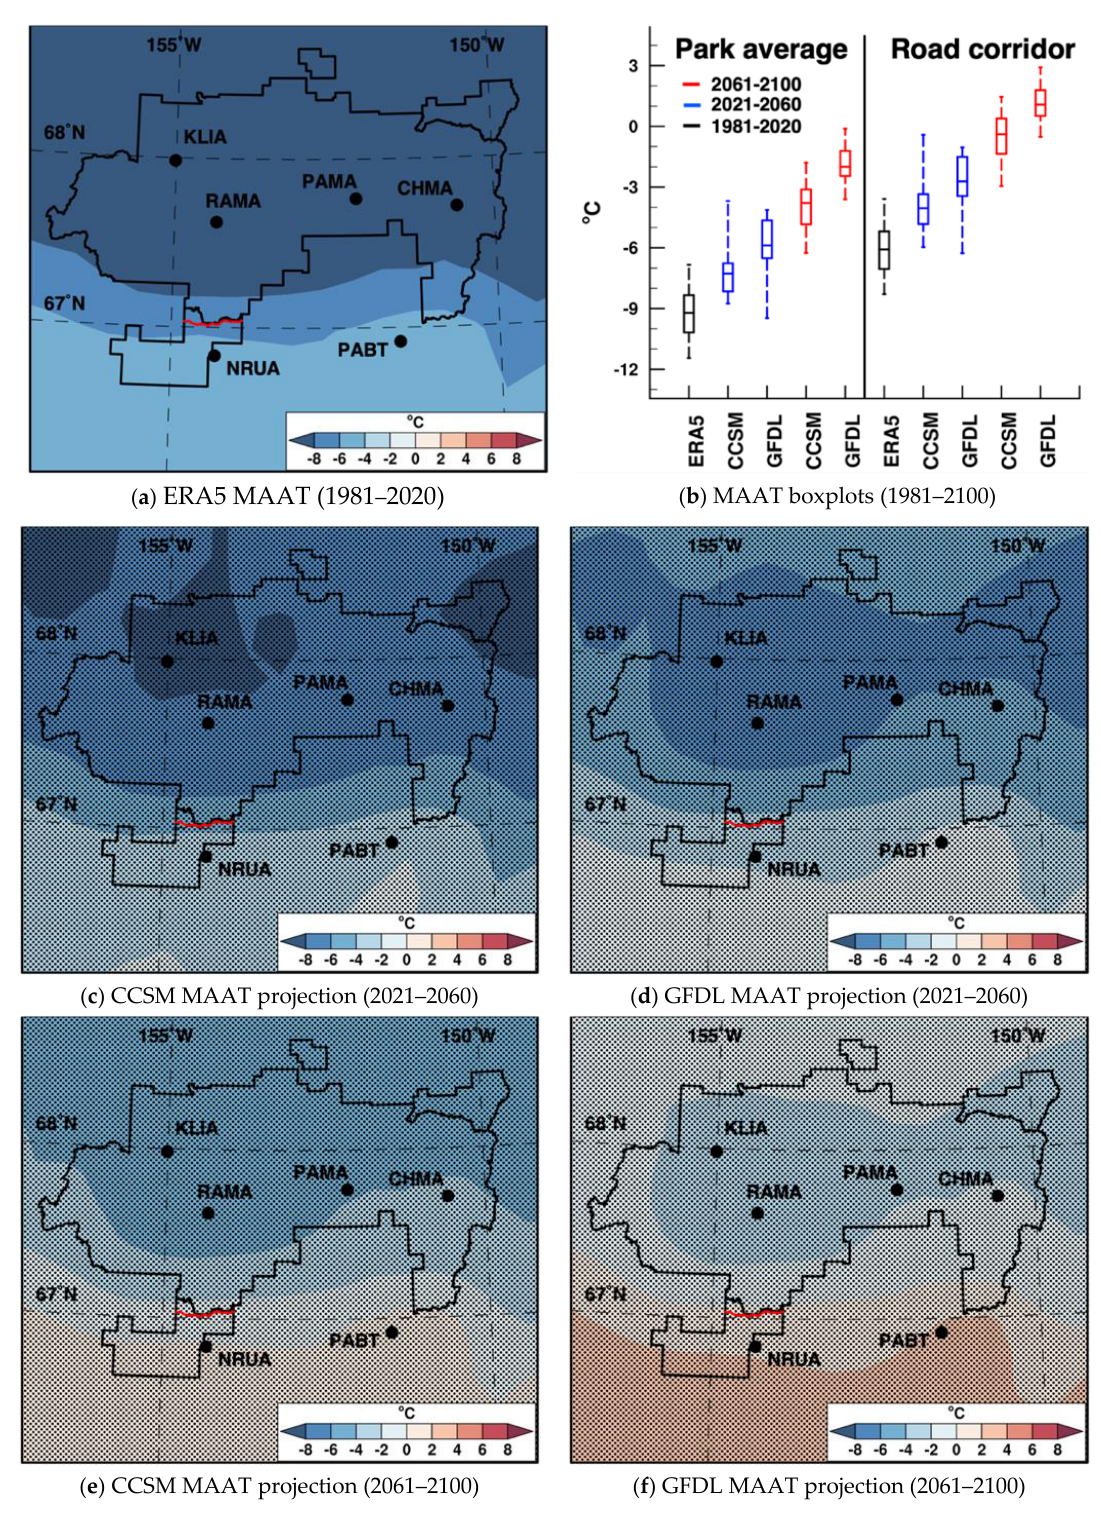
Figure 6. Gates of the Arctic ( a ) ERA5 mean annual air temperature (MAAT) climatology (°C), ( b ) park-average (left) and road corridor (right) boxplots of MAAT, and bias-corrected: mid-century MAAT projections from ( c ) CCSM and ( d ) GFDL and late-century MAAT projections from ( e ) CCSM and ( f ) GFDL. All projections are significant at the 95% confidence level (shaded with stippling).